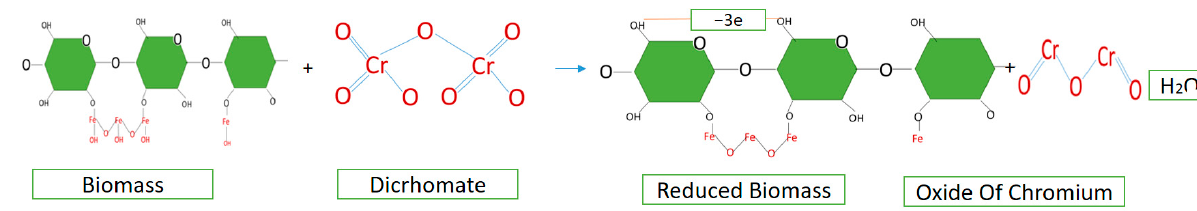
Figure 5. Representation of Cr (VI) reduction to Cr (III).